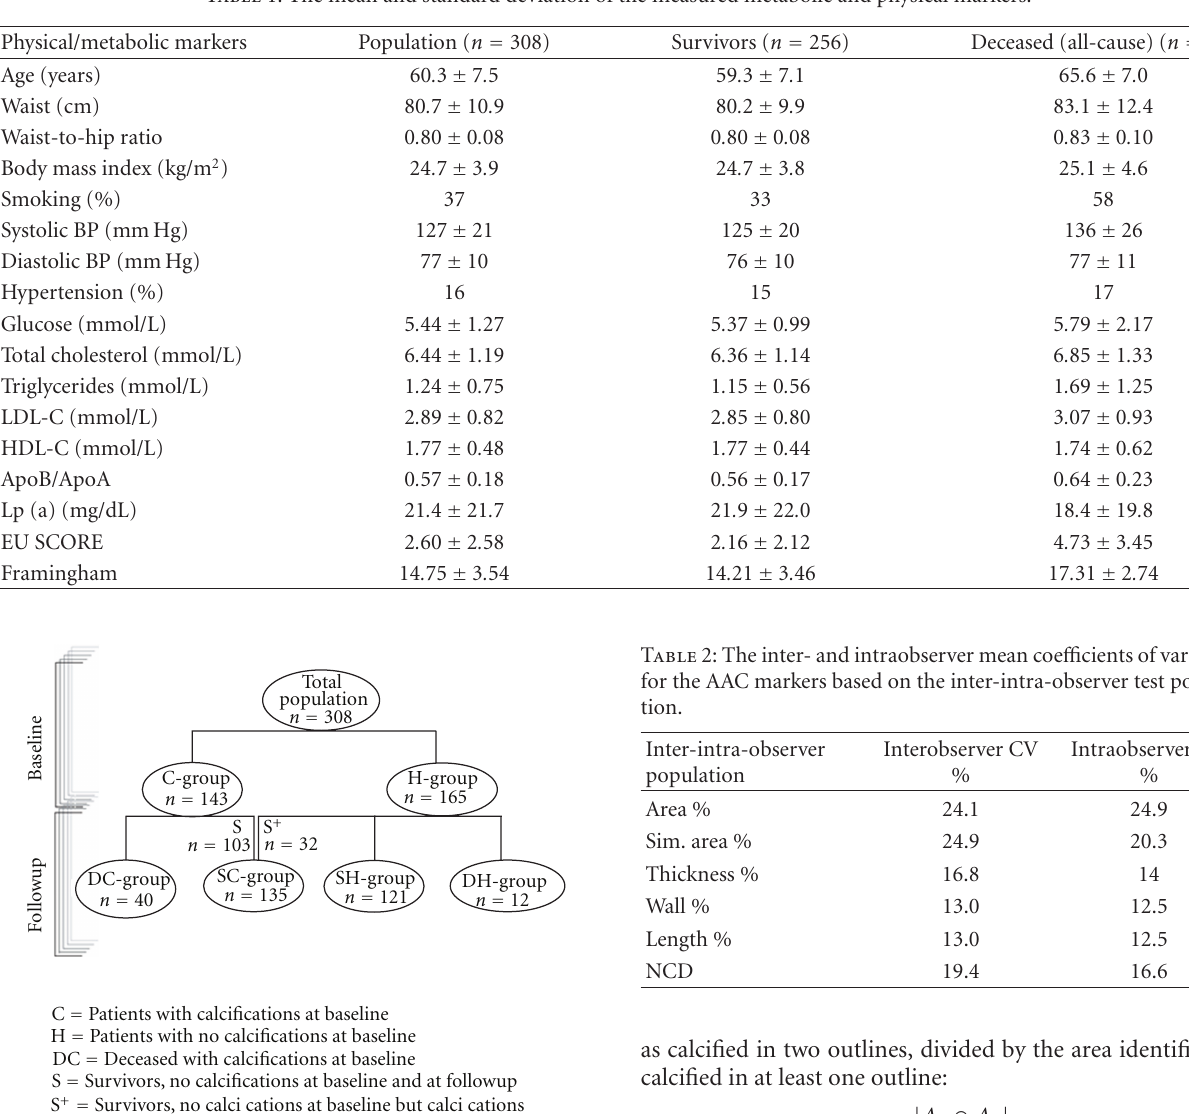
Table 1: The mean and standard deviation of the measured metabolic and physical markers.